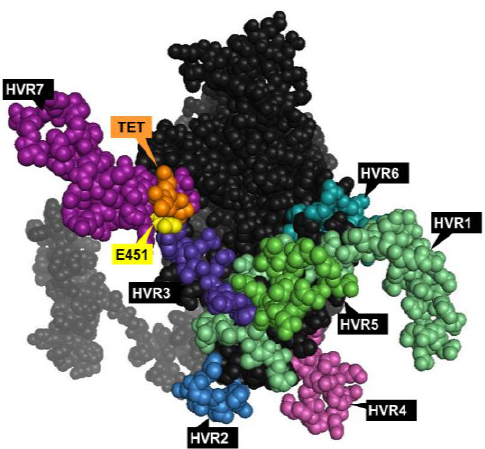
Figure 2. Top view of the Ad5 hexon monomer with the major antigenic epitopes. Hypervariable regions (HVRs) 1‒7 [33] shown in different colors; the site for point mutation (E451Q) central for ablation of human coagulation factor X (FX) binding [26] is shown in yellow; TET motif central for the high affinity interaction with coagulation factor VII (FVII) shown in orange [38]. The model was generated in PyMol version 1. 1eval (PDB ID: 3TG7).